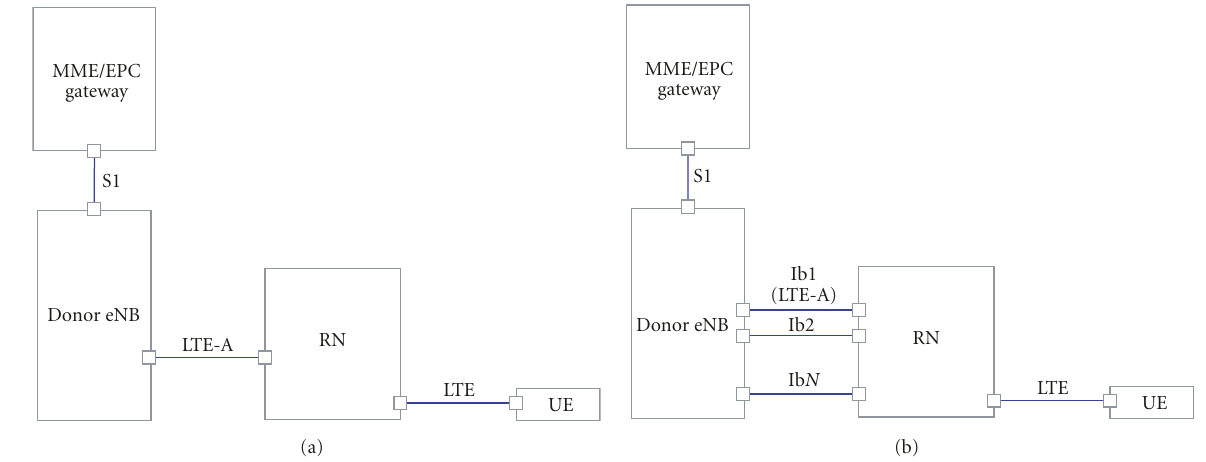
Figure 5: Interfaces between di ff erent network elements, (a) single mode RNs, (b) multimode RNs.